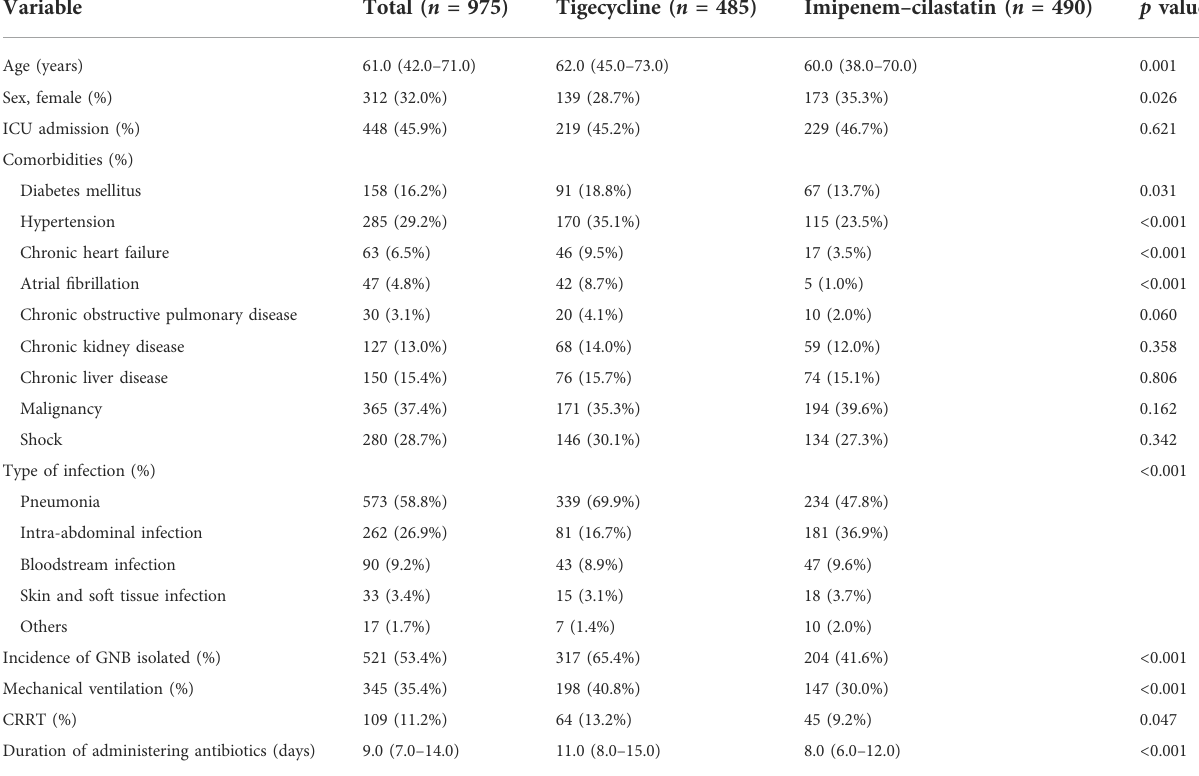
TABLE 1 Patient characteristics.